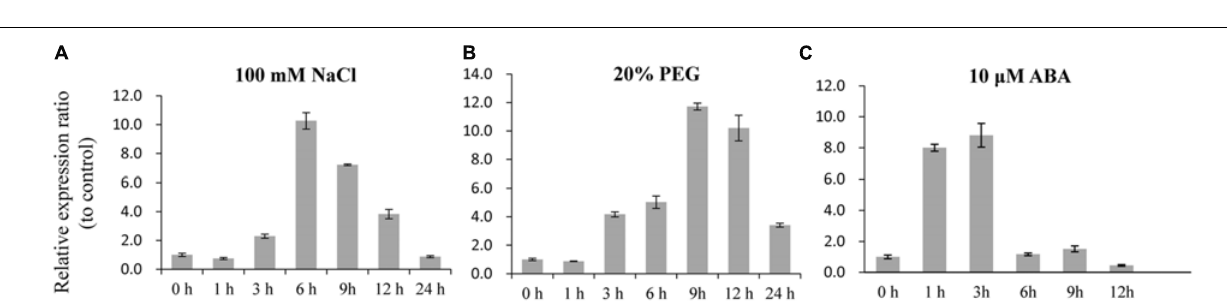
FIGURE 2 | SiLTP transcript accumulation in response to various treatments. Two-week-old foxtail millet seedlings were treated independently with 100 mM NaCl (A) , 20% (m/v) PEG 6000 (B) , and 10 µ M ABA (C) for the indicated